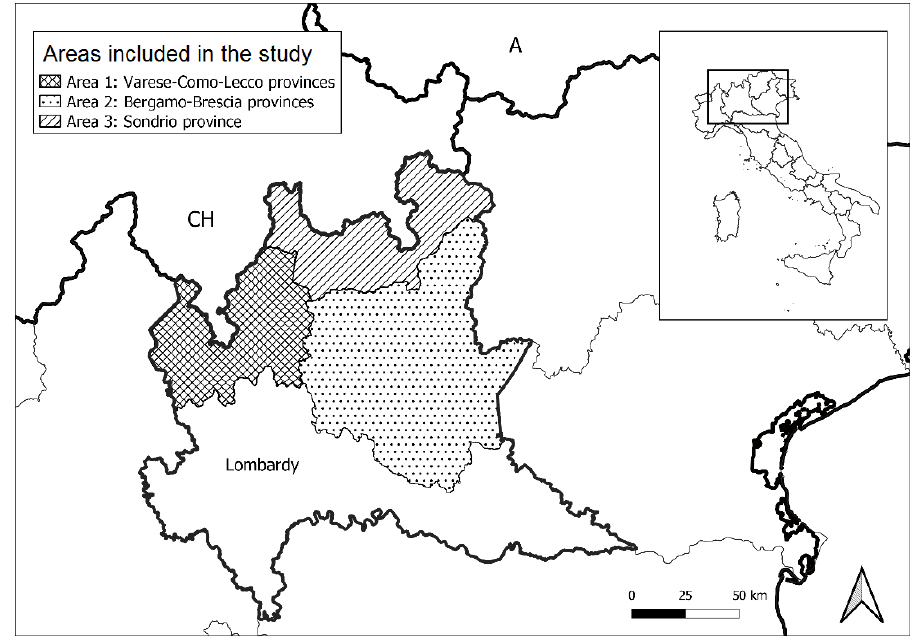
Figure 1. Representation of the three areas within the Lombardy region in north Italy.